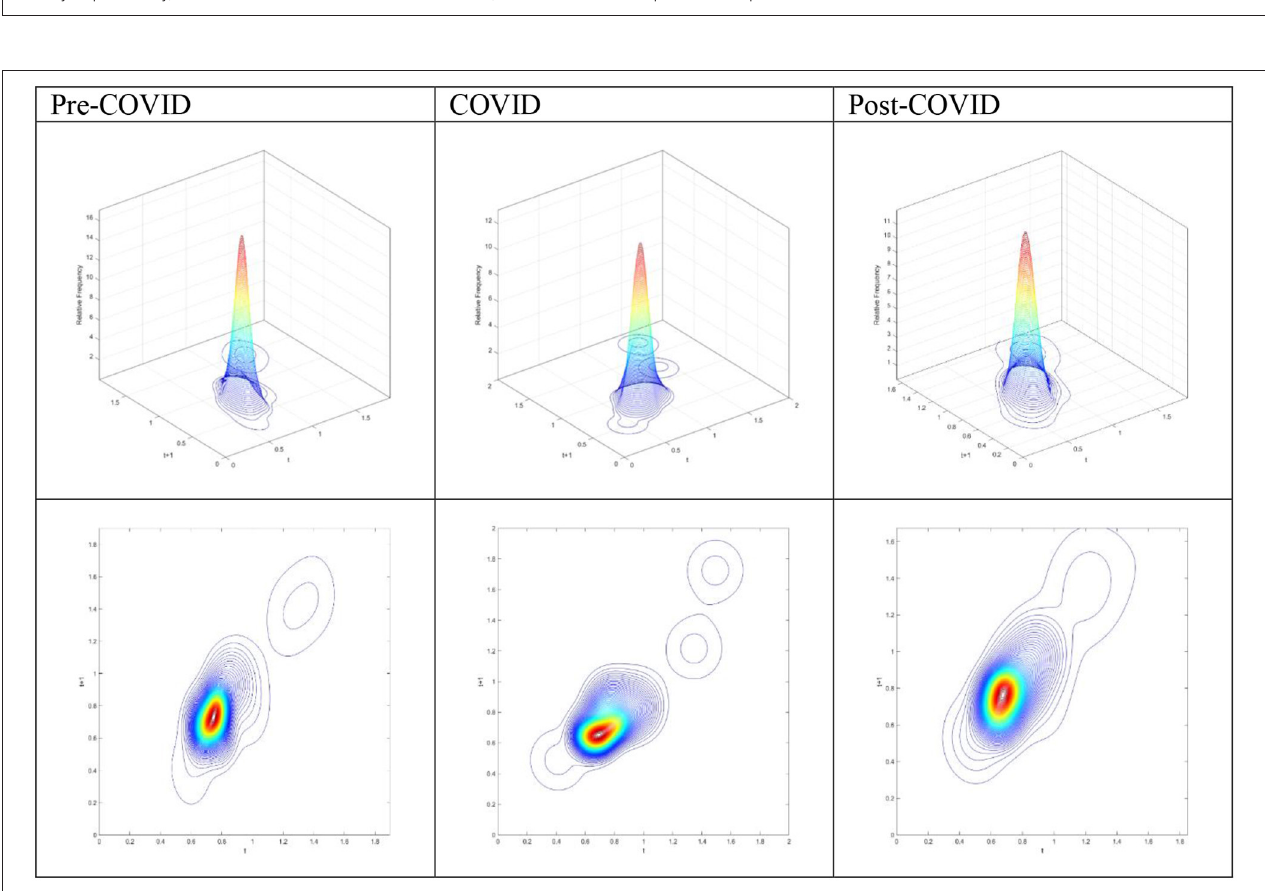
FIGURE 7 | Three-dimensional plot and Contour map of transition probability kernel for the RDIPC of all residents in cities with the shortest duration of Level I ERS with quarterly transitions during the Pre-COVID, COVID, and Post-COVID periods. Source: authors’ calculation.